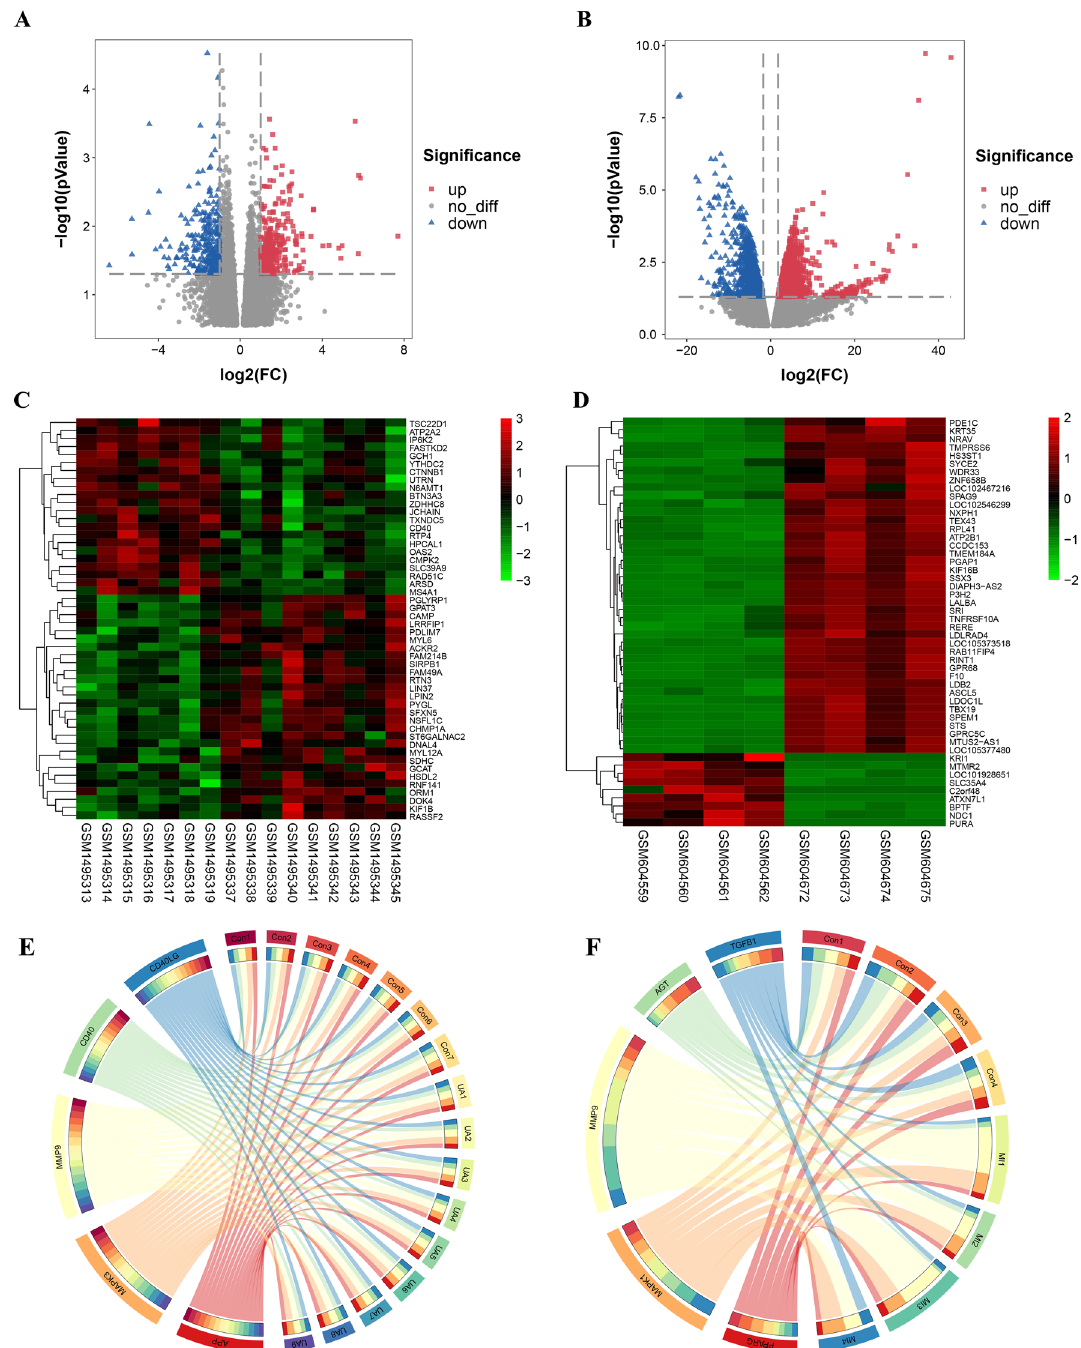
Figure 1. Differentially expressed genes between unstable angina/myocardial infarction and control groups. ( A,C) Volcano plot and cluster heat map of the top 50 differentially expressed genes from GSE60993. ( B,D) Volcano plot and cluster heat map of the top 20 differentially expressed genes from GSE24519. ( E,F) Screened the gene correlation maps between the top 5 genes of UA and MI and their corresponding samples. Red represents the upregulated genes based on |log2FC|> 1 and P value < 0.05 and blue represents the downregulated genes based on the same statistical